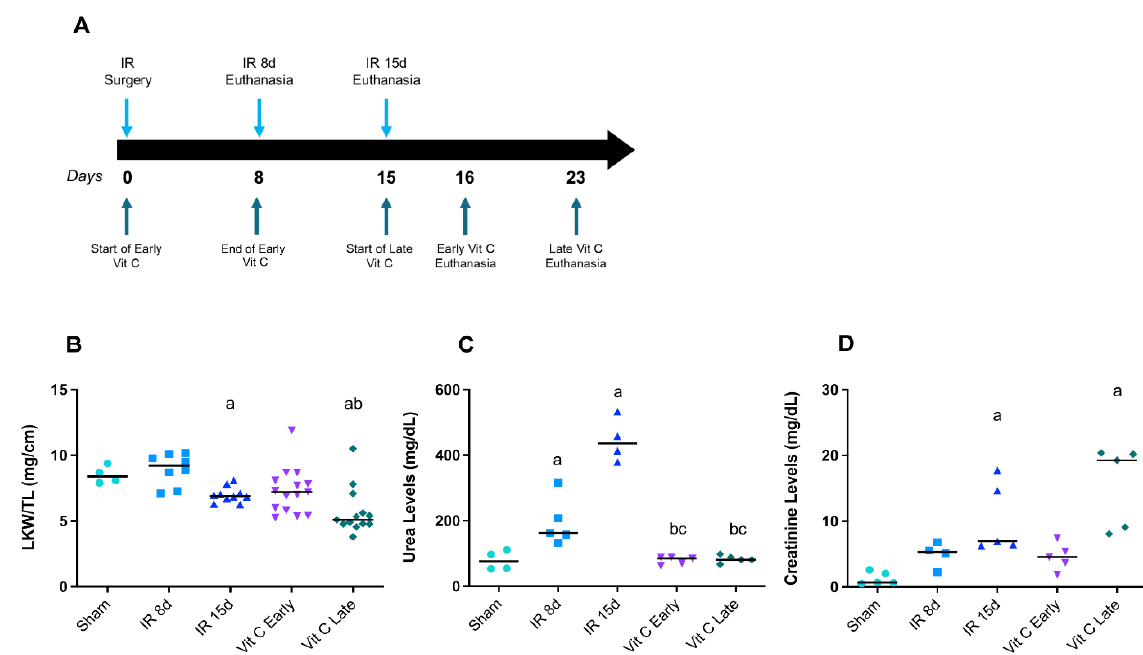
Figure 1. Effect of vitamin C on renal function after IR protocol. Experimental design of the ischemia and reperfusion (IR) protocol and treatments with vitamin C ( A ), left kidney weight/tibia ratio (mg/cm) ( B ), urea serum concentration (mg/dL) ( C ), and creatinine serum concentration (mg/dL) ( D ) in all different groups. Data are expressed as the mean ± standard error of mean (SEM), and one-way ANOVA followed by the Tukey’s post hoc test were performed. a vs. sham, p < 0.05. b vs. IR8d, p < 0.05. c vs. IR15d, p < 0.05.